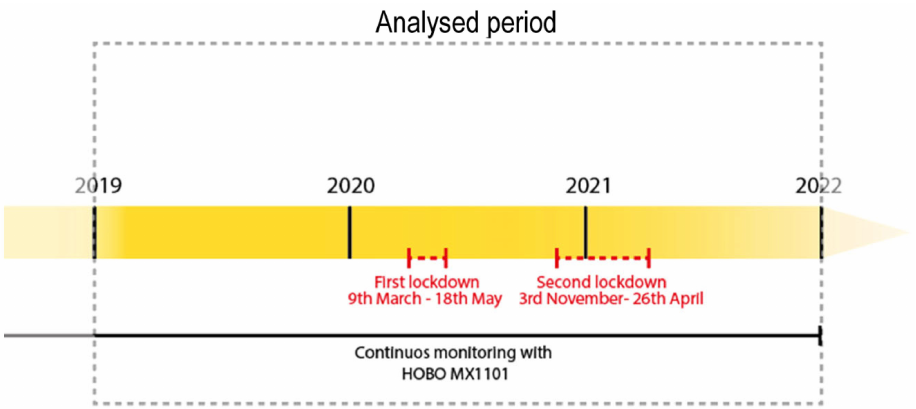
Figure 4. A timeline with the main monitoring